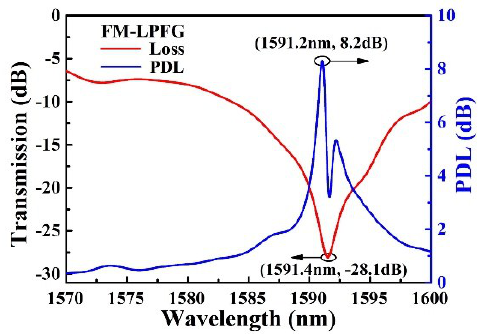
Figure 2. Measured transmission spectrum of the polarization-dependent loss (PDL) for the LPFG.